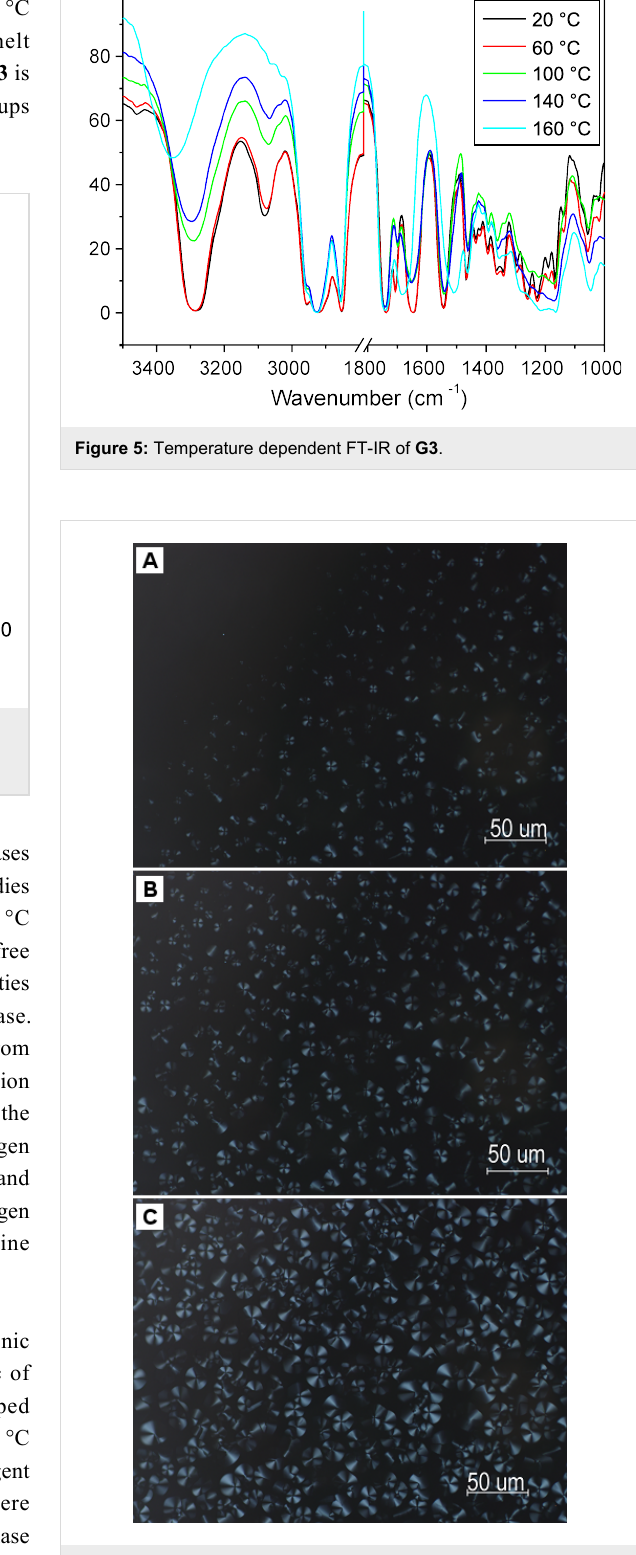
Figure 6: . Polarized optical micrographs of G3 at 145 °C (A), 140 °C (B), and 50 °C